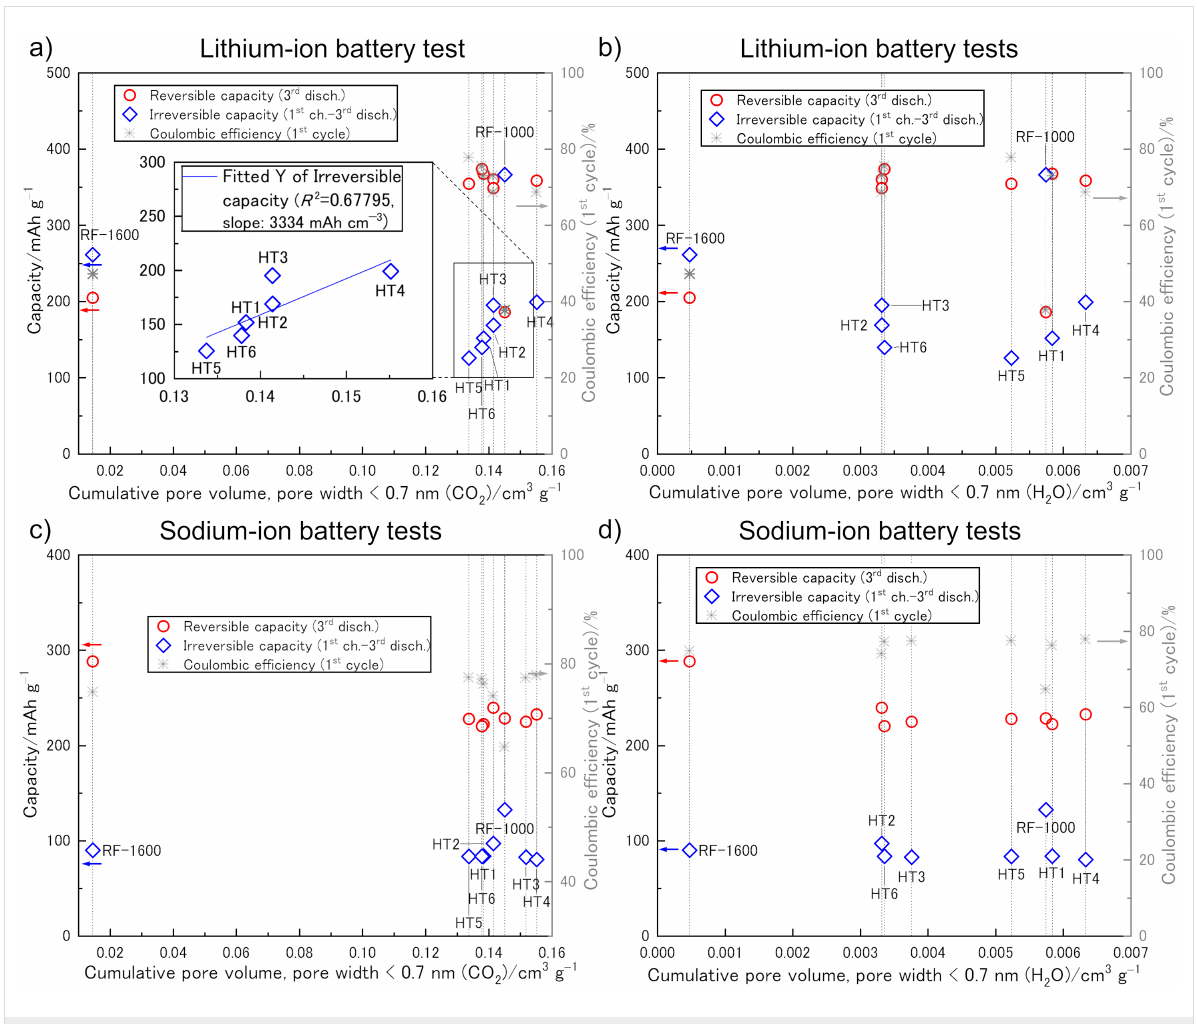
Figure 4: Capacities (reversible: red circle, irreversible: blue diamond, Y -axis) and Coulombic efficiencies (gray asterisk, R -axis) against cumulative pore volumes (obtained from CO 2 adsorption by Monte Carlo method (a, c) and from H 2 O adsorption by Mahle method (b, d)) of lithium (a, b) and so- dium (c, d). The inset in (a) is an enlargement of the irreversible capacity trend of HT carbons (blue line: approximate straight line of irreversible capacity of HT carbons. Slope: 3334 mAh cm − 3 , coefficient of determination, R 2 =